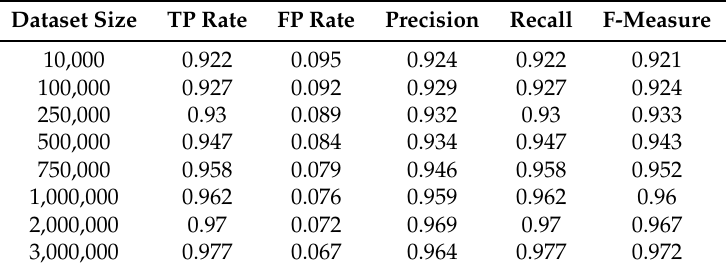
Table 5. Classification of J48 for different dataset sizes.